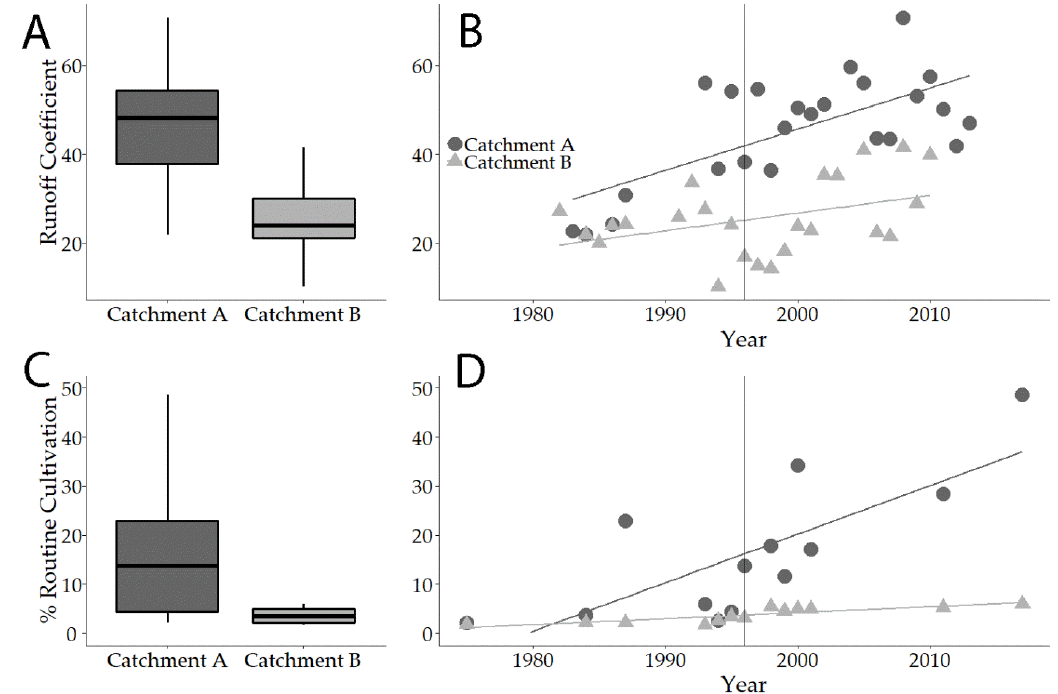
Figure 6. ( A ) Boxplot of runoff data in adjacent catchment areas A and B of the Moho watershed; ( B ) Runoff coefficient over time (1987–2012); ( C ) Boxplot of routine cultivation data in catchments A and B; and ( D ) Percentage of landscape under routine cultivation over time (1975–2017).